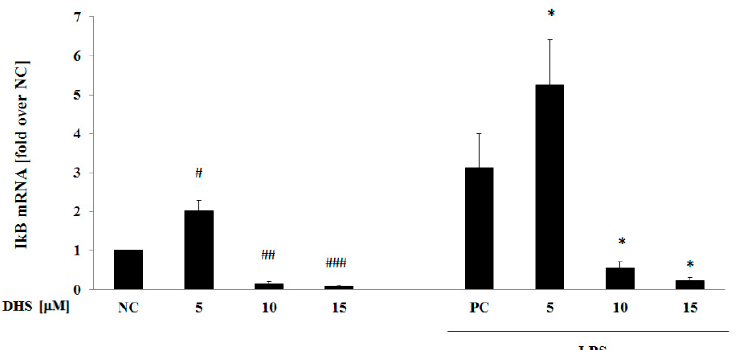
Figure 6. Effect of DHS on I κ B mRNA level with or without previous LPS challenge. Gene expression analysis was conducted using quantitative RT-PCR after 24 h of exposure to 5–15 µ M DHS with or without previous 6 h LPS challenge. RPL13A was used as an internal standard. Data are presented as the mean percentage relative to NC ± SEM ( n = 3), significantly different from NC ( # p < 0.05; ## p < 0.01;